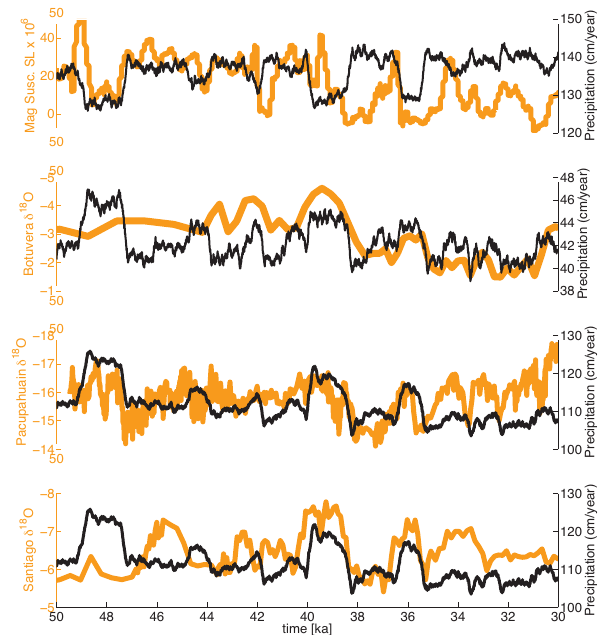
Fig. 6. From top to bottom: time series of simulated annual pre- cipitation anomalies over Guatemala (104–93 ◦ W, 12–30 ◦ N) com- pared to a magnetic susceptibility record from Lake Peten Itza, Guatemala (Hodell et al., 2008); Brazil (44–60 ◦ W, 20–30 ◦ S) com- pared to δ 18 O (‰) of a speleothem record from Botuvera Cave, Brazil (Wang et al., 2007); Peru and Ecuador (85–70 ◦ W, 3–15 ◦ S) compared to speleothems δ 18 O records from Pacupahuain Cave, Peru (Kanner et al., 2013) and Santiago Cave, Ecuador (Mosblech et al., 2012). Model results are in black and paleoproxy records in